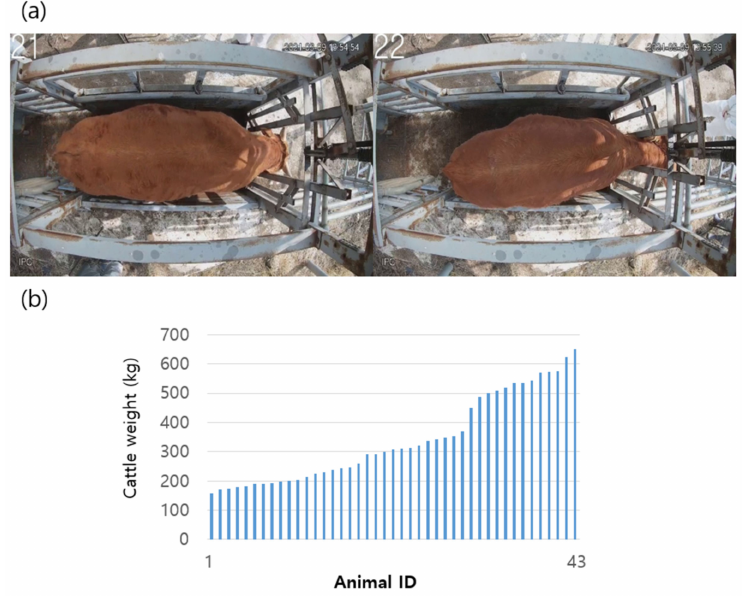
Figure 3. Collected research data: ( a ) examples of top-view image data; ( b ) weight distribution